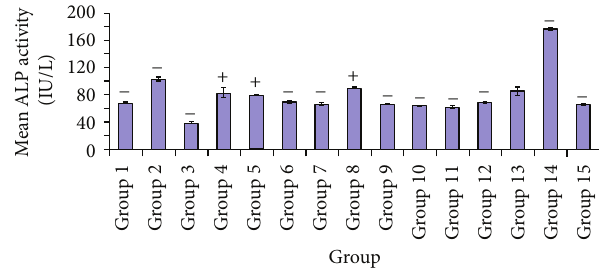
Figure 8: Comparative effects of different plants extracts on alkaline phosphatase (ALP) level.